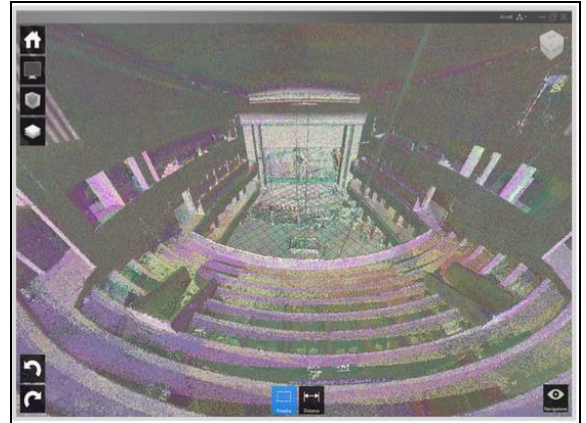
Figure 2. Point cloud of the interior of the Lyric Theatre Source: Municipality of